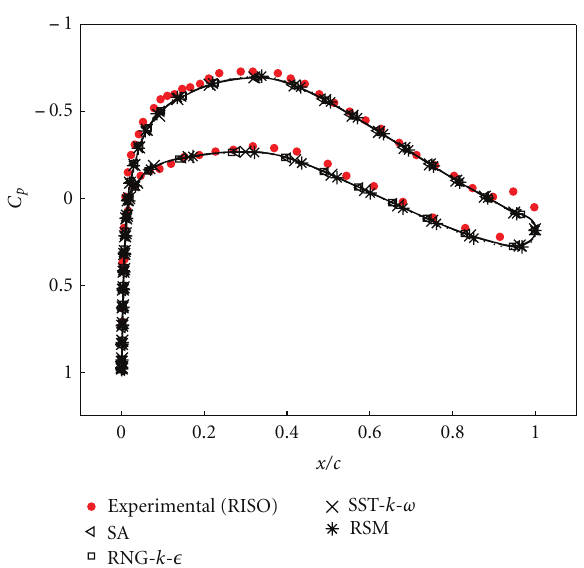
Figure 6: Pressure coe ffi cient at 0 ◦ following application of various turbulence models.